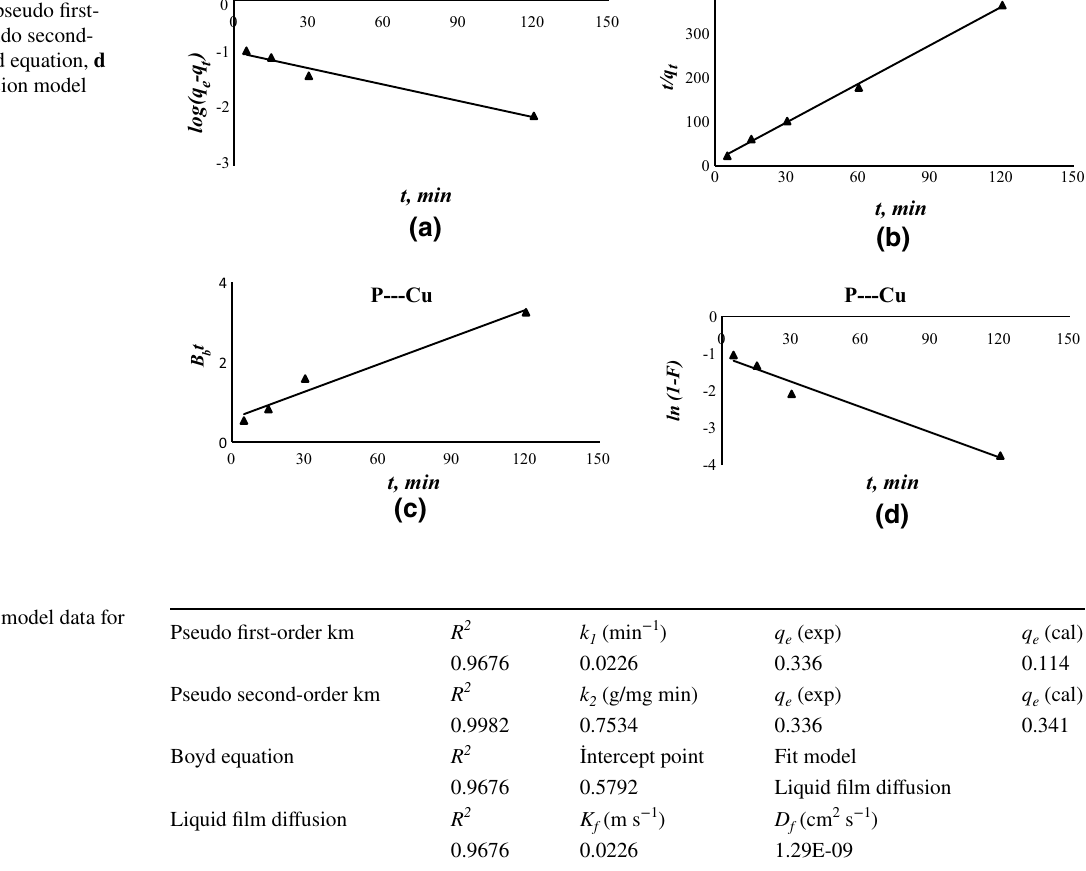
Fig. 3 Reaction and diffusion- based models: a pseudo first- order k.m, b pseudo second- order k.m, c Boyd equation, d Liquid film diffusion model